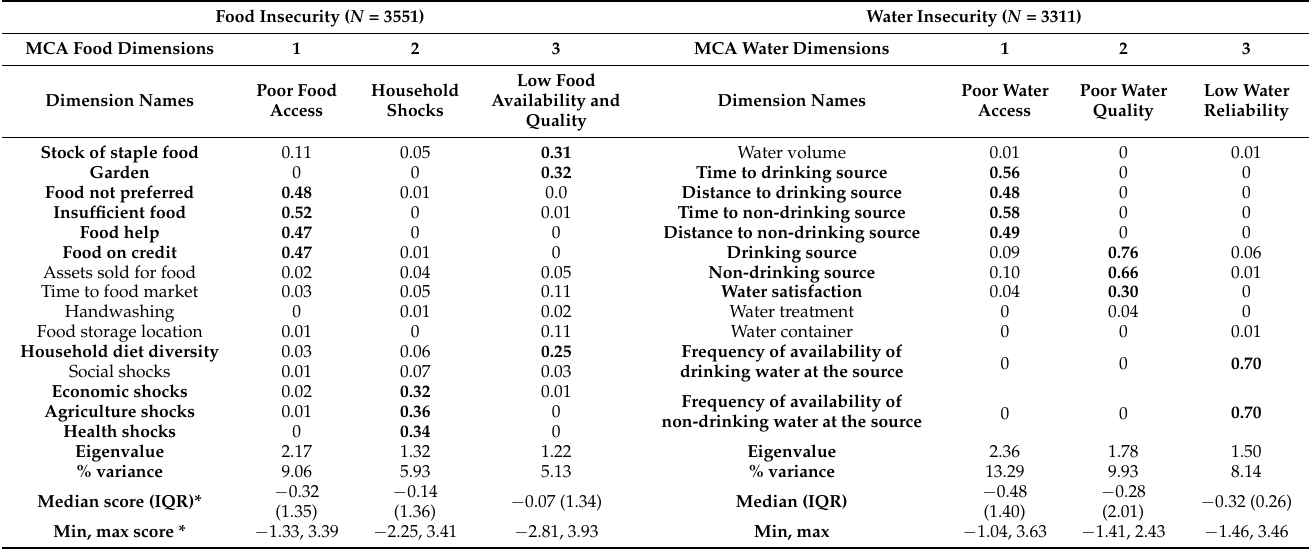
Table 4. Squared correlation ratios, eigenvalues, percentage variances and descriptive statistics of multiple correspondence analysis for final dimensions in each food insecurity and water insecurity measures. Food Insecurity ( N =